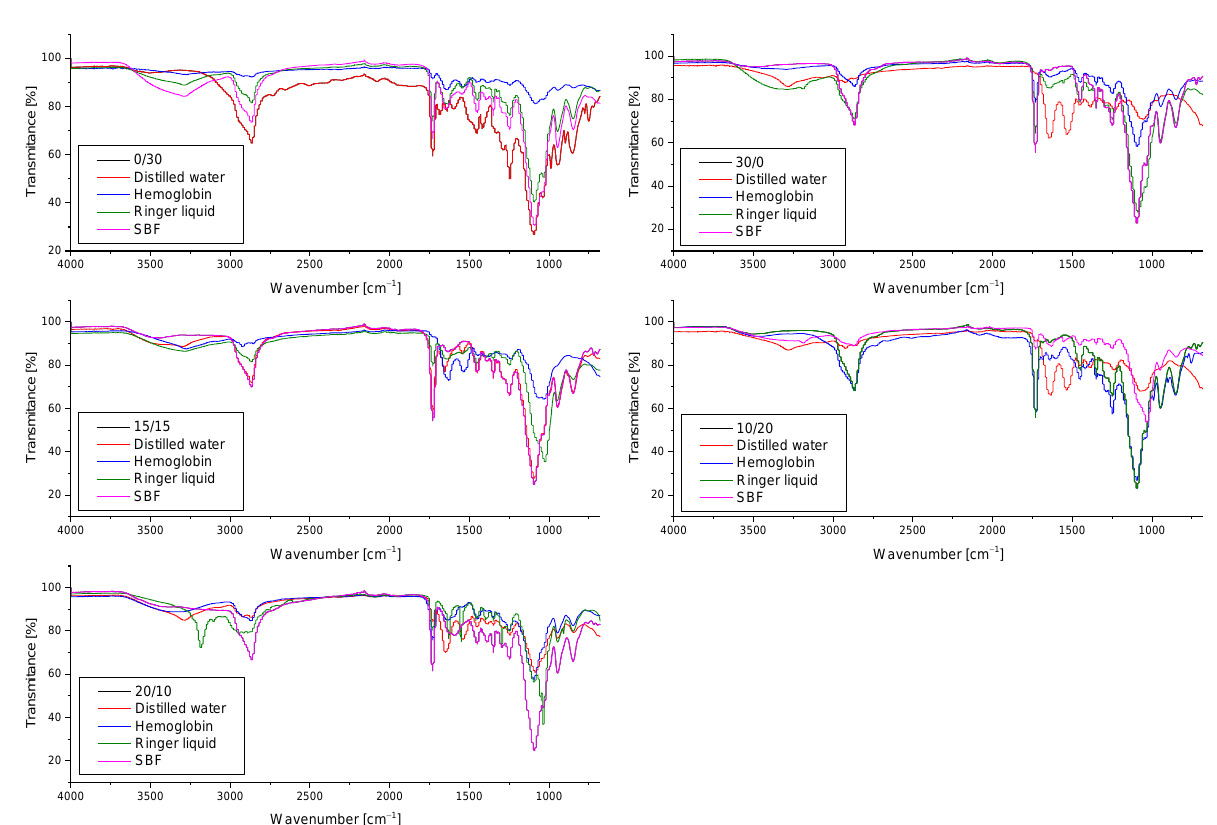
Figure 6. FT-IR spectra showing the impact of the incubation studies on the structure of unmodified chitosan/poly(aspartic acid)-based hydrogel